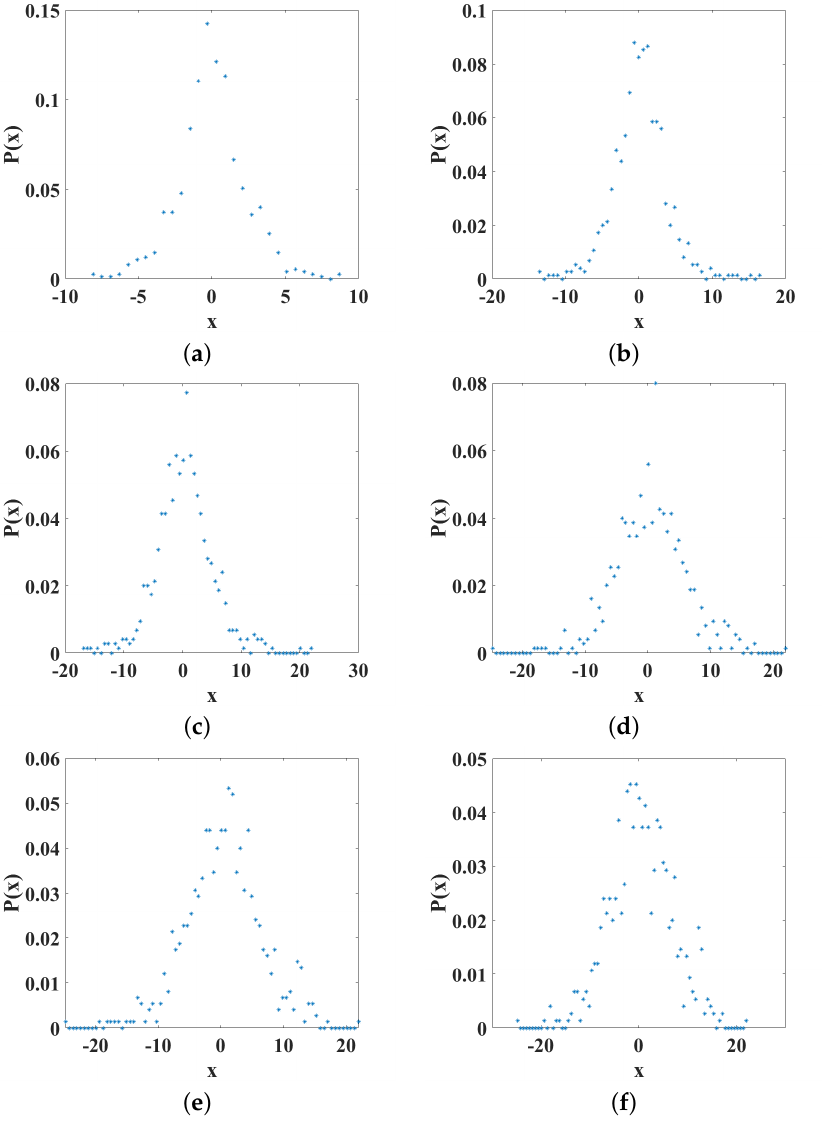
Figure 11. Probability distributions of settling location with changes in m . ( a ) m = 4; ( b ) m =